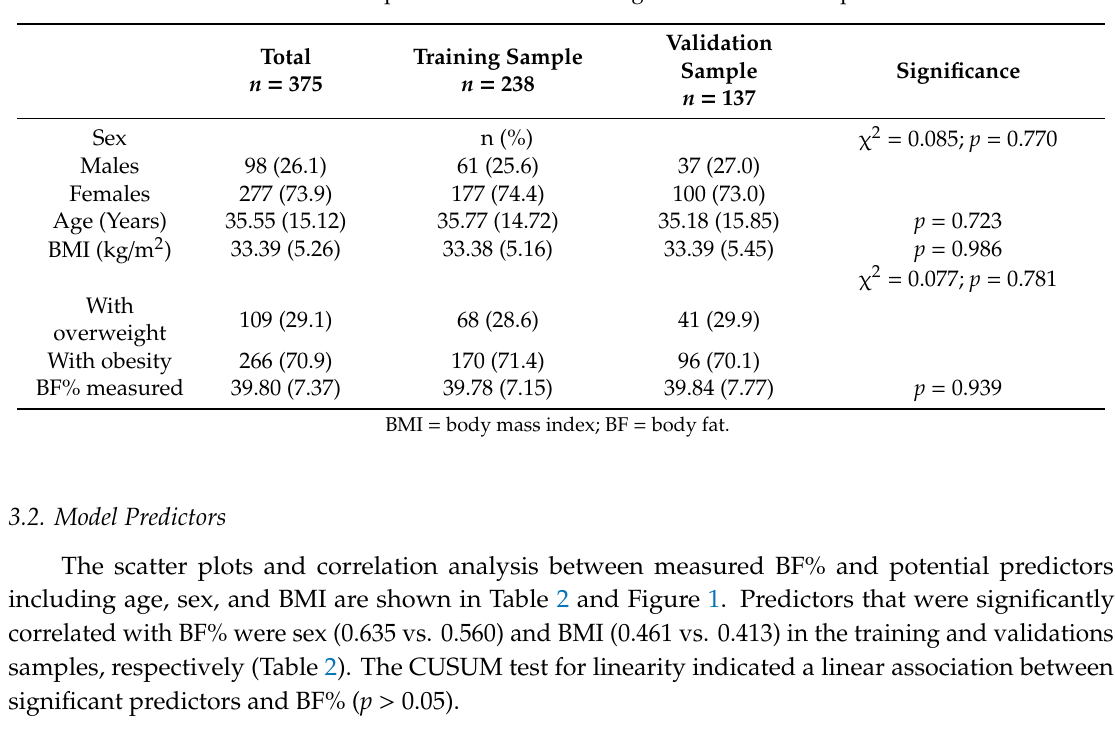
Table 1. Descriptive statistics for training and validation samples.